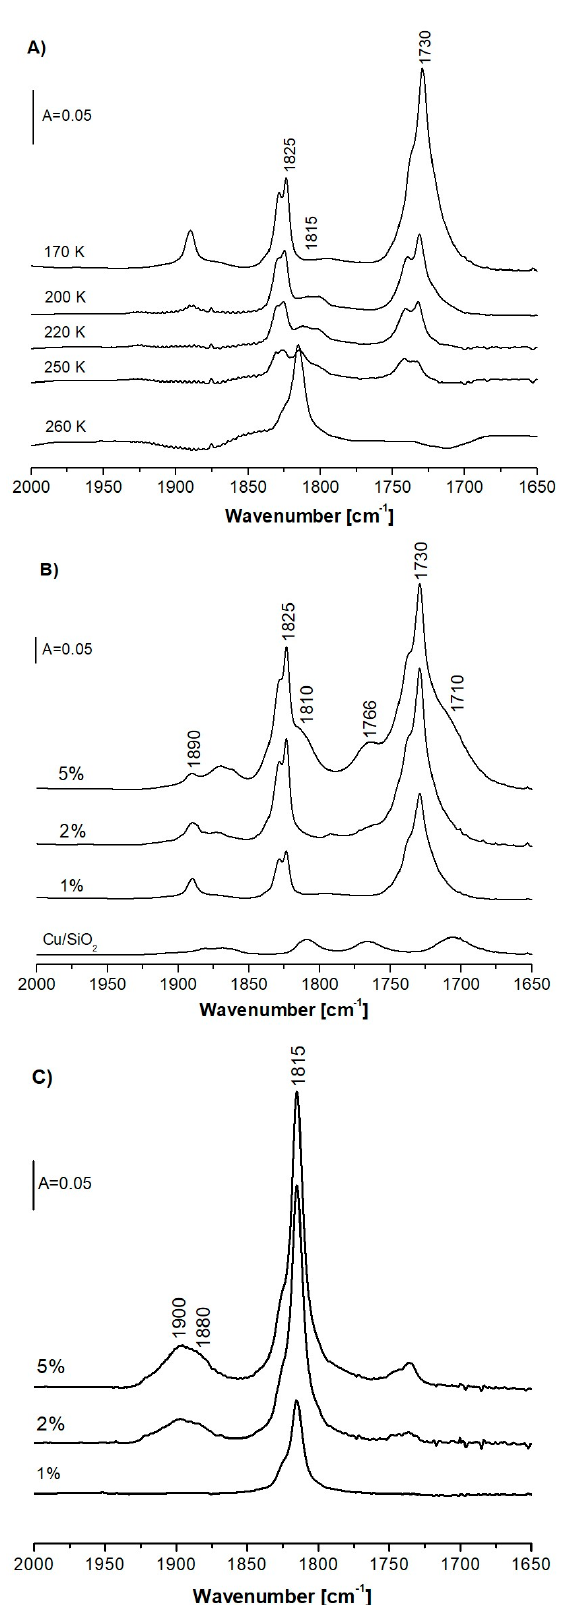
Figure 6. ( A )—The spectra recorded upon the sorption of NO in zeolite Cu(1)HFAU at 170 K and upon heating of zeolite with NO to 200, 220, 250, and 260 K. ( B ), ( C )—The spectra of NO sorbed in CuHFAU zeolites at various Cu contents at 170 K ( B ) and at room temperature ( C ).